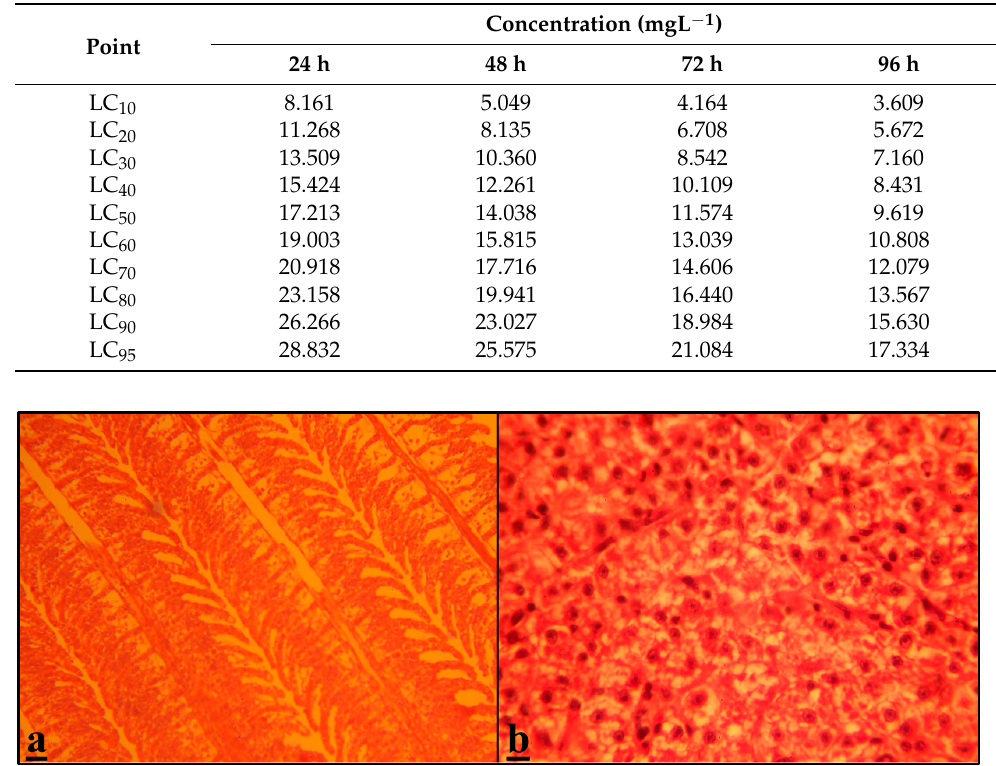
Figure 1. ( a , b ) Tissue sample of Capoeta (Capoeta capoeta ) in the control group (0 mgL − 1 of Ag-NPs); ( a ) gills of fish (magnified ×40); ( b ) liver of fish (magnified ×40).